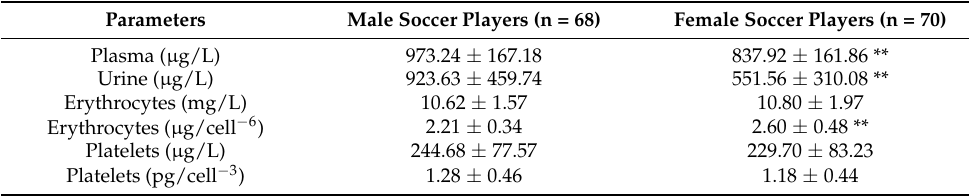
Table 6. Zn concentrations in extracellular and intracellular biological matrices.